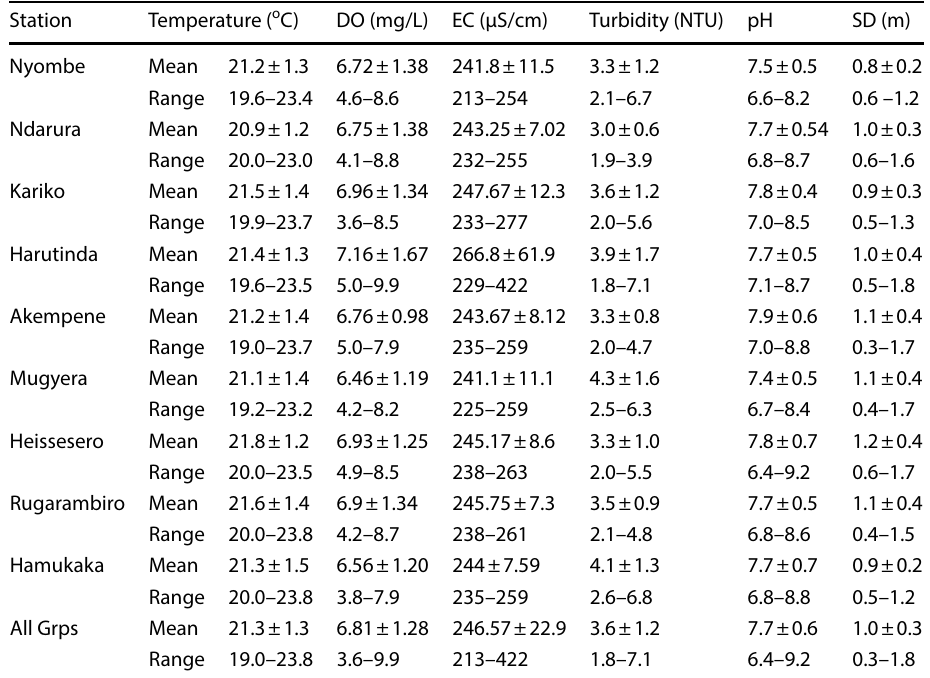
Table 3 Mean ± SD of physicochemical parameters at different sampling points ( n = 108)